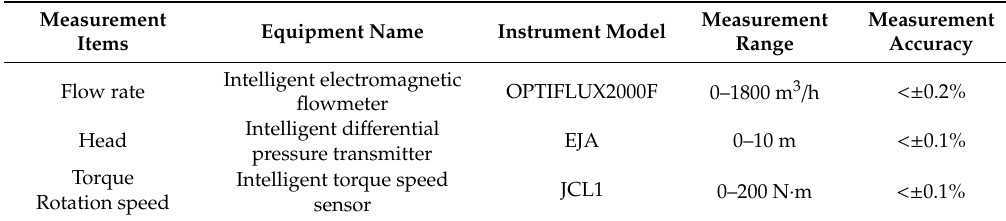
Table 8. Main technical parameters of measurement equipment.